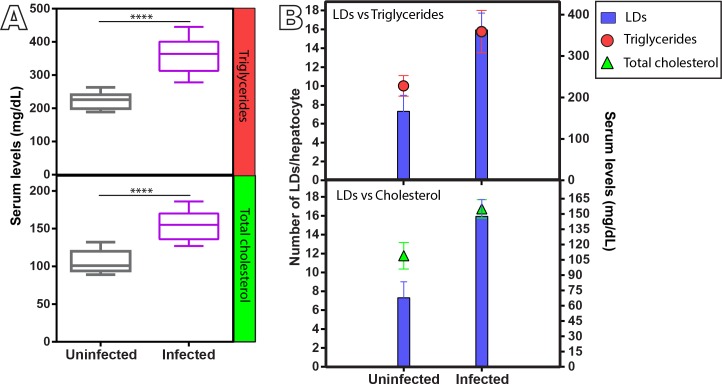
Serum lipid profile of uninfected and naturally S. mansoni-infected N. squamipes.(A) The levels of total cholesterol and triglycerides are significantly increased in the infected group in comparison to the uninfected animals (****P < 0.0001, n = 13 animals per group). (B) Serum lipids increase proportionally to the increase of LD numbers in the liver. LDs were counted in the liver after ORO staining as shown in Fig 2. Data represent minimum-median-maximum (A) and mean ± S.D (B).